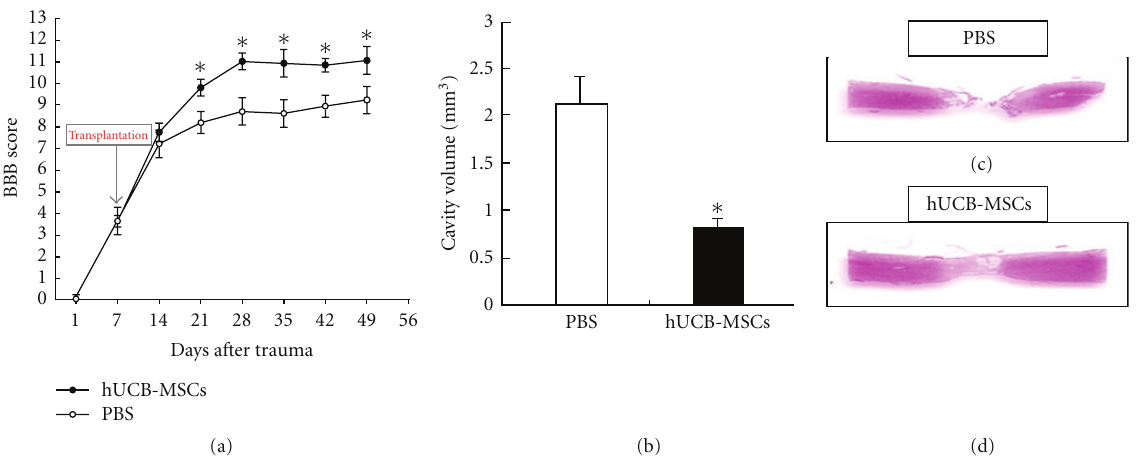
Figure 1: BBB scores of rats with SCI before and after hUCB-MSCs transplantation at 7 days after SCI. (a) hUCB-MSC transplantation group displayed significantly improved scores compared with control at 6 weeks after transplantation. (b) Cavity volume between the hUCB-MSC and control groups at 6 weeks after transplantation. The values of the cavity volume of the hUCB-MSC group were lower than those of the control group. (c) and (d) HE-stained sections of transplantation group and control group, P < 0 . 05.